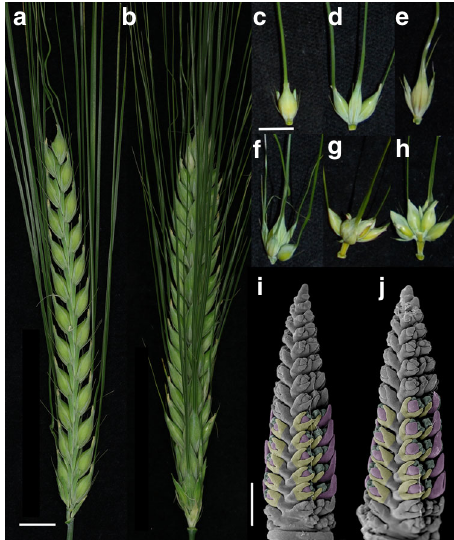
Fig. 1 The vrs3 phenotype. a Spike of the two-rowed cv . Bowman. b Spike of the vrs3 NIL BW419( int- a. 1 ). Scale bar in a applies to b , 1 cm. c Bowman spikelet triplet with fertile central and infertile lateral spikelets. d – h Spikelet triplets from a homozygous vrs3 individual from the BW419( int- a. 1 ) *Bowman F2 population. d Six-rowed spikelet triplet. e Spikelet triplet with fertile central spikelet and infertile, pointed lateral spikelets. f – h Spikelet triplet with additional fertile spikelets and awned palea. g Adaxial and h abaxial views of the same spikelet triplet showing the formation of additional fl orets within the central spikelet. Scale bar in c applies to d – h , 1 cm. i , j Scanning electron microscopy of developing spikes of i Bowman and j vrs3 NIL BW902( vrs3 . f ). Developing lemmas are highlighted in pink, anthers in green and glumes in yellow. Scale bar in i applies to j , 500 µ